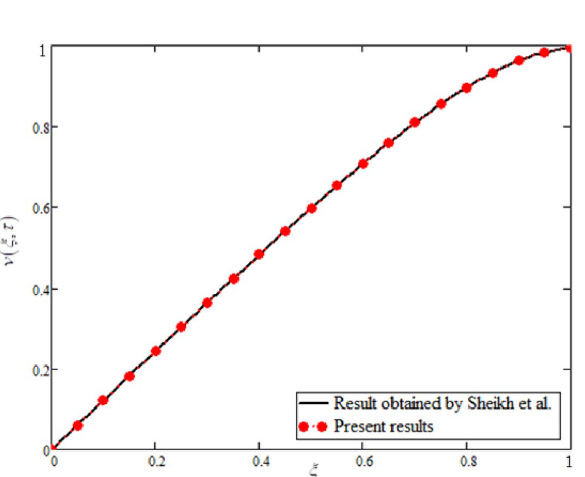
Figure 11. Variation in concentration profile for various values of φ , when α π β 22.64 , and Sc 1 , γ 1 , Pr , M 4 , = = = =